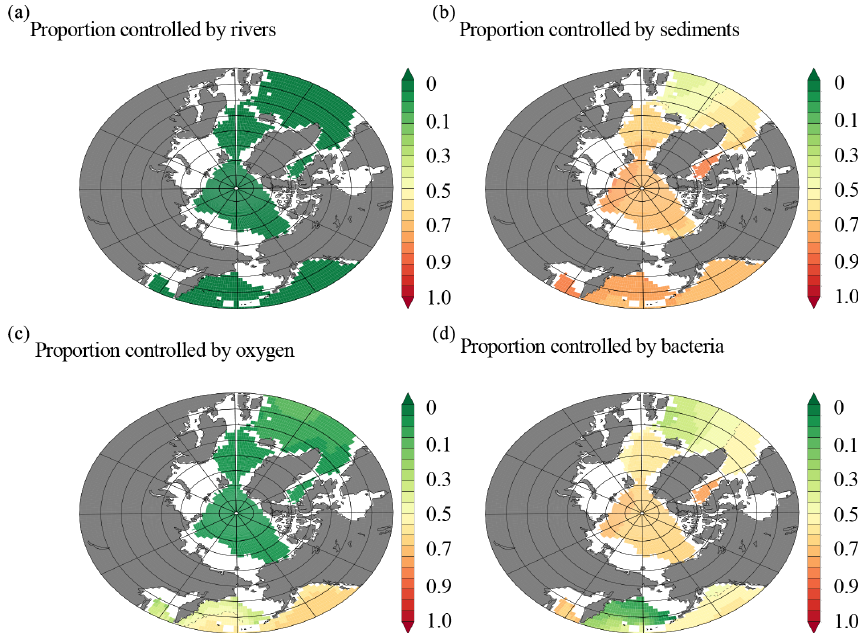
Figure 10. (a) Model output of the proportion of the dCo signal from 700 to 800m that is controlled by (a) rivers, (b) sediment input, (c) oxygen concentrations, and (d) removal by Mn oxidation from Mn-oxidizing bacteria.